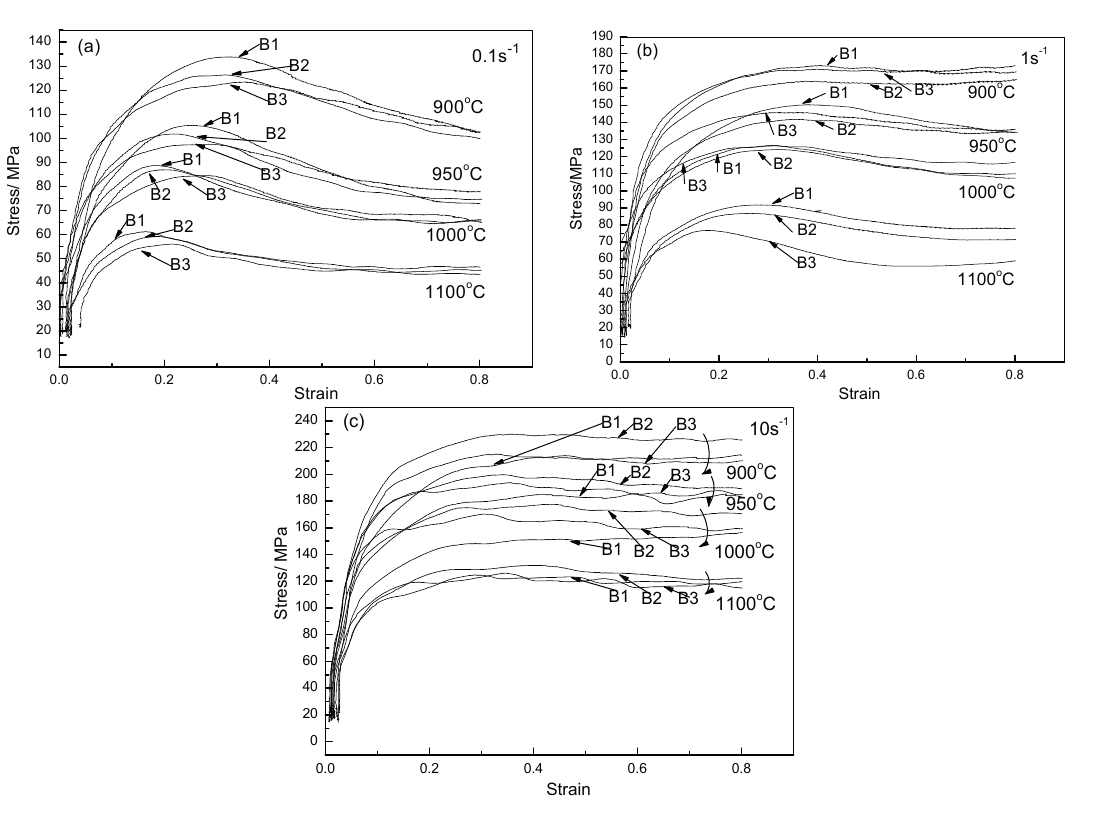
Figure 5. Flow curves for different steels at different temperatures and strain